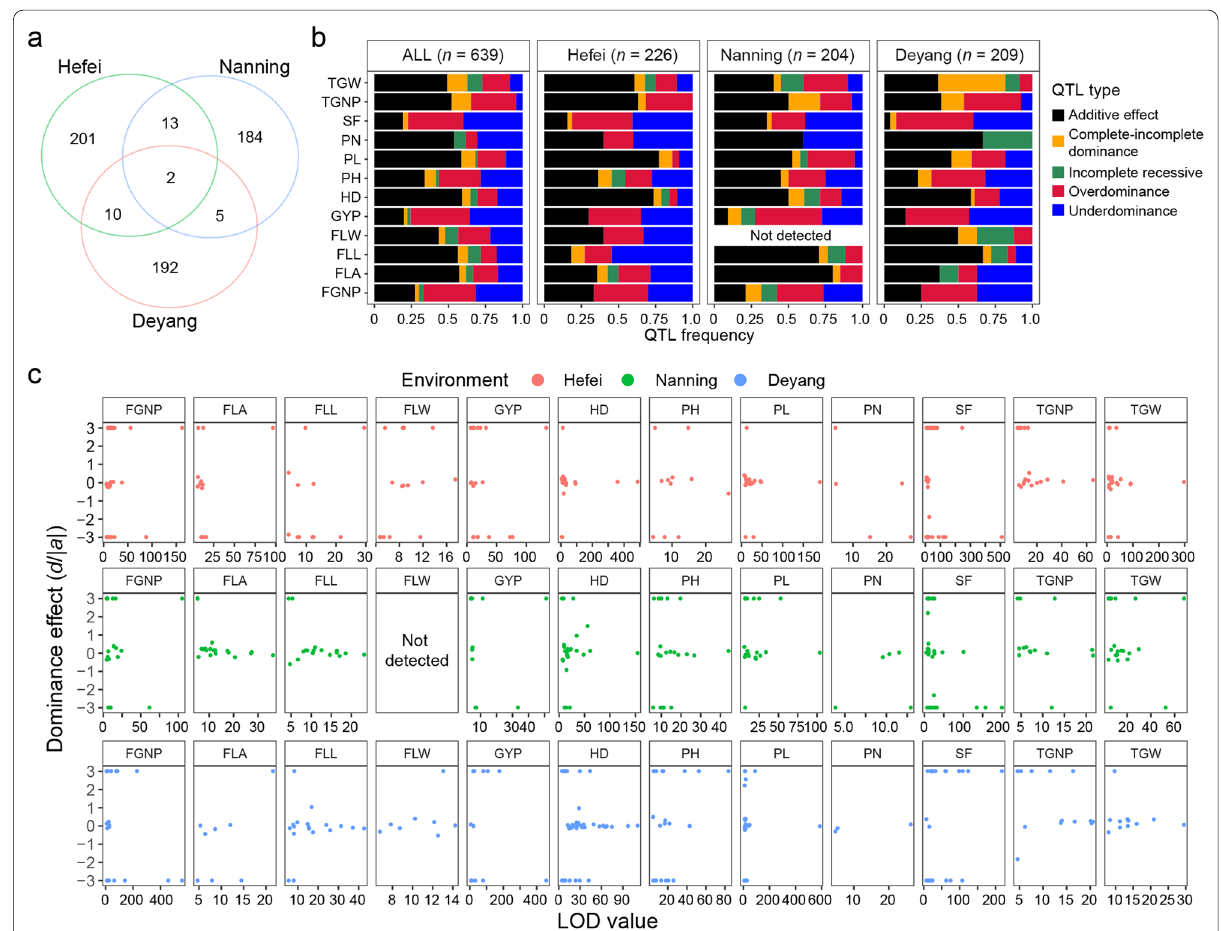
Fig. 3 Comparison of the main-effect QTLs showing different gene actions affecting yield traits detected in combined population across three environments. a Venn diagram showing the numbers of co-localized QTL among three environments. b Frequencies of five gene actions of main-effect QTLs for 12 traits in three environments. c Plots of the dominance effects ( d /| a | values) and their LOD values of the QTLs for 12 traits in Hefei, Nanning and Deyang. The QTLs with d /| a | values of > 3 or < –3 are plotted to be